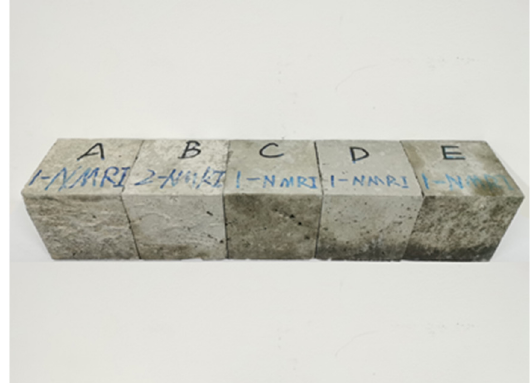
Figure 2. LF-NMR test blocks.